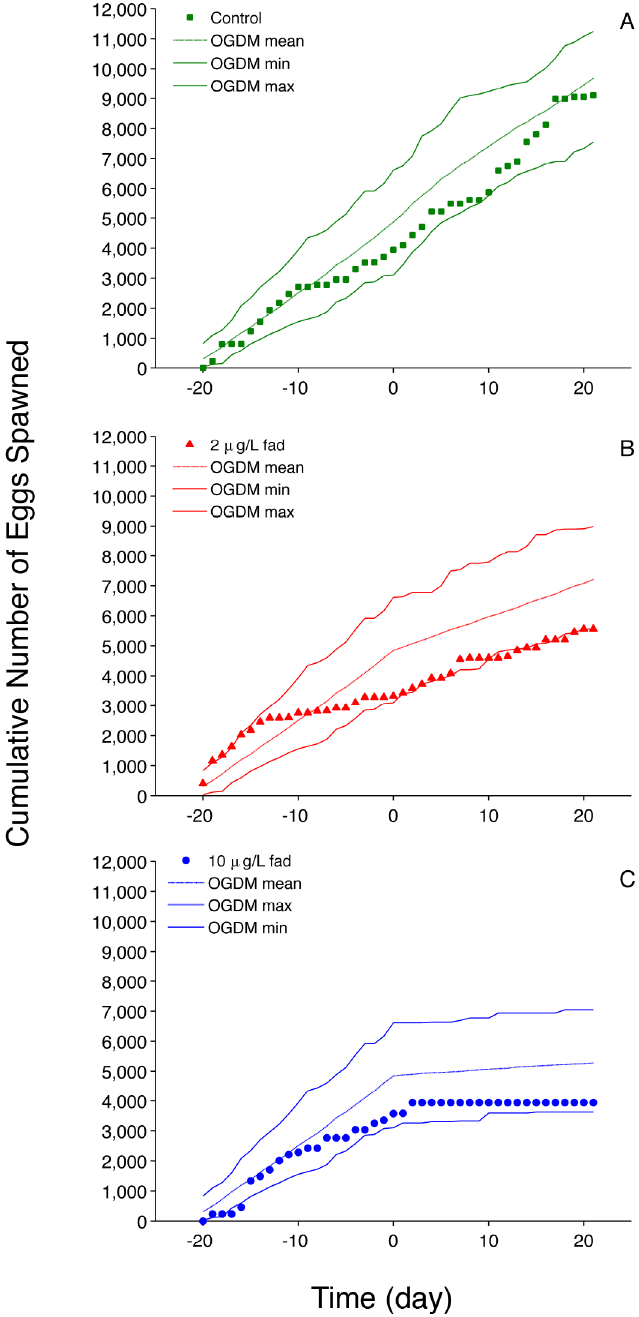
Fig 4. Fadrozole (fad) Cumulative Fecundity. Pre-exposure days reported as negative values; exposure began on day 0. (A) control (0 μ g fad (cid:129) L -1 ); (B) 2 μ g fad (cid:129) L -1 exposure; (C) 10 μ g fad (cid:129) L -1 exposure. Filled markers represent experimental data [8]; dashed lines represent the mean of 50 cumulative fecundity model predictions; solid lines represent the minimum and maximum cumulative fecundity values of 50 OGDM model